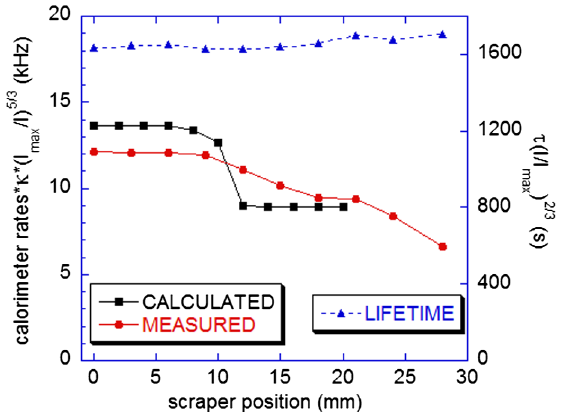
FIG. 8. Scan of the background rate in the KLOE forward calorimeter versus position of the internal jaw of the scraper SCHPL110: measured (calculated) normalized rate in red dots (black squares) and normalized measured lifetime in blue